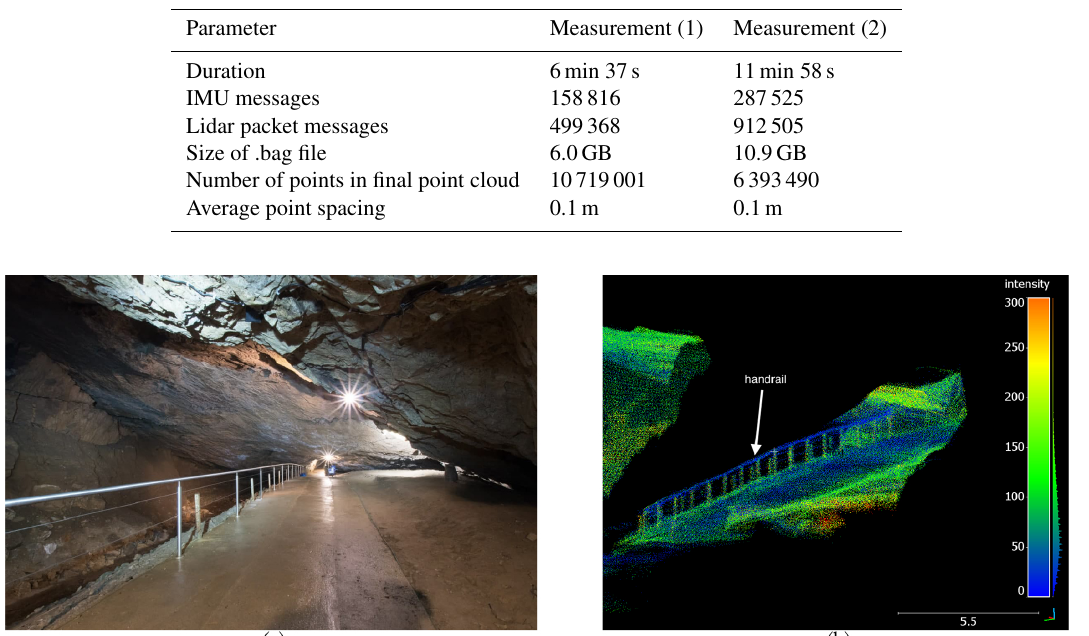
Figure 6. Panel (a) shows karst shapes, concrete, and metal structures in the Lurgrotte cave (image by Christian Bauer). Panel (b) shows a detailed image of the cave section including the walking path and handrail (created with